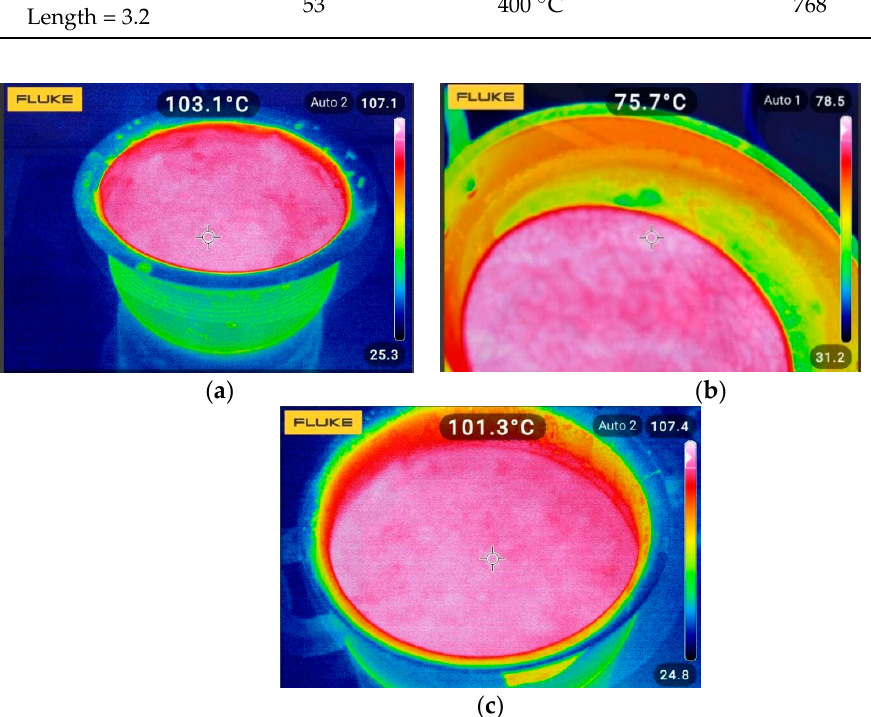
Figure 17. Thermal image of heating different metals: ( a ) stainless steel; ( b ) aluminium; ( c ) copper (power rating: 2kW and time period: 100 s). (power rating: 2 kW and time period: 100